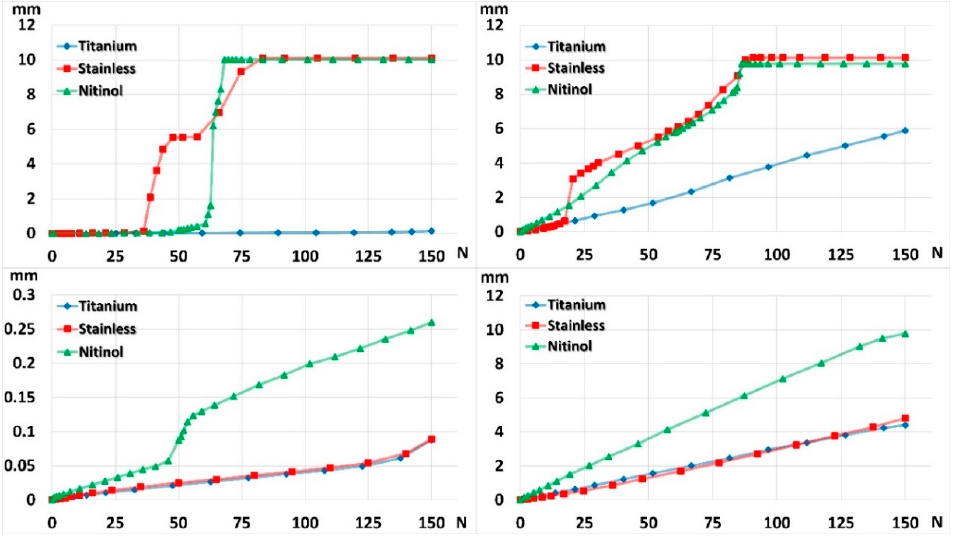
Figure 7. Gap shortening with ( bottom row ) and without ( top row ) end cap in compression ( left column ) and bending ( right column ).